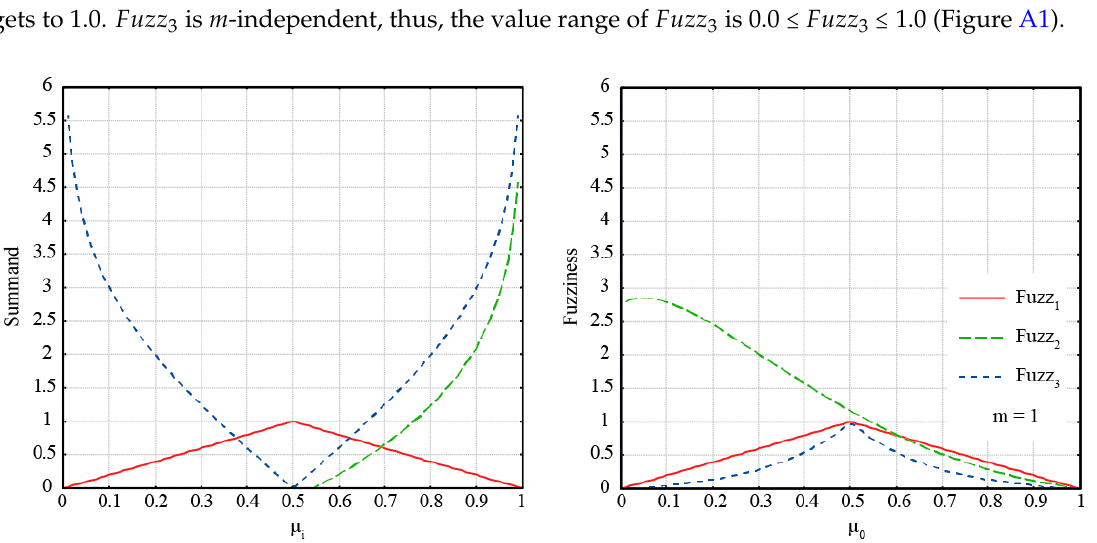
Figure A1. Dependency of the summand for the calculation of fuzziness from μ i ( left ) and the fuzziness from μ (for only one class, right ).